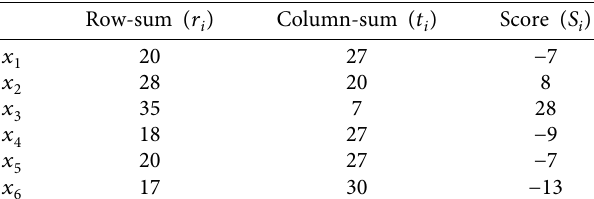
Table 3: o i scores.